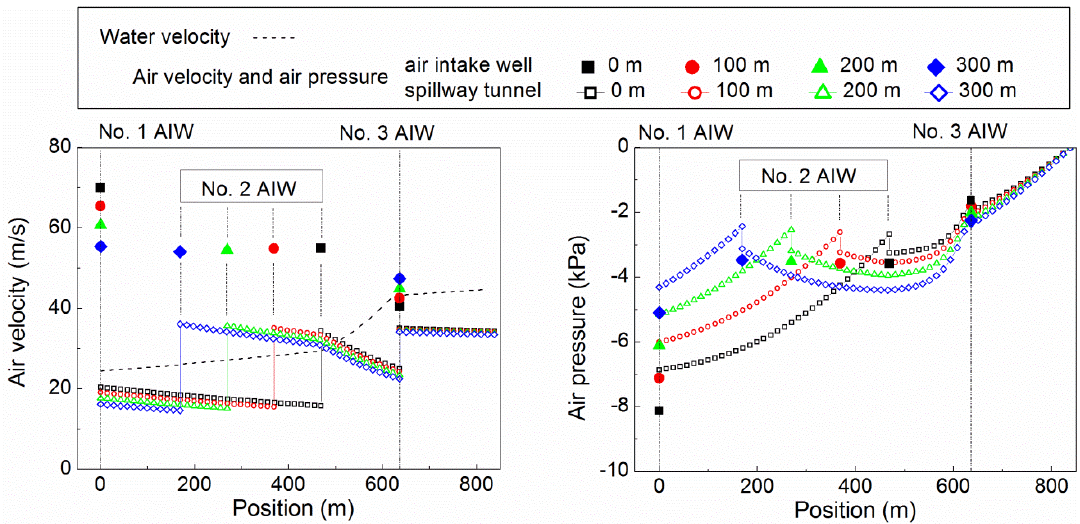
Figure 11. Influence of the location of air intake wells on ventilation characteristics.